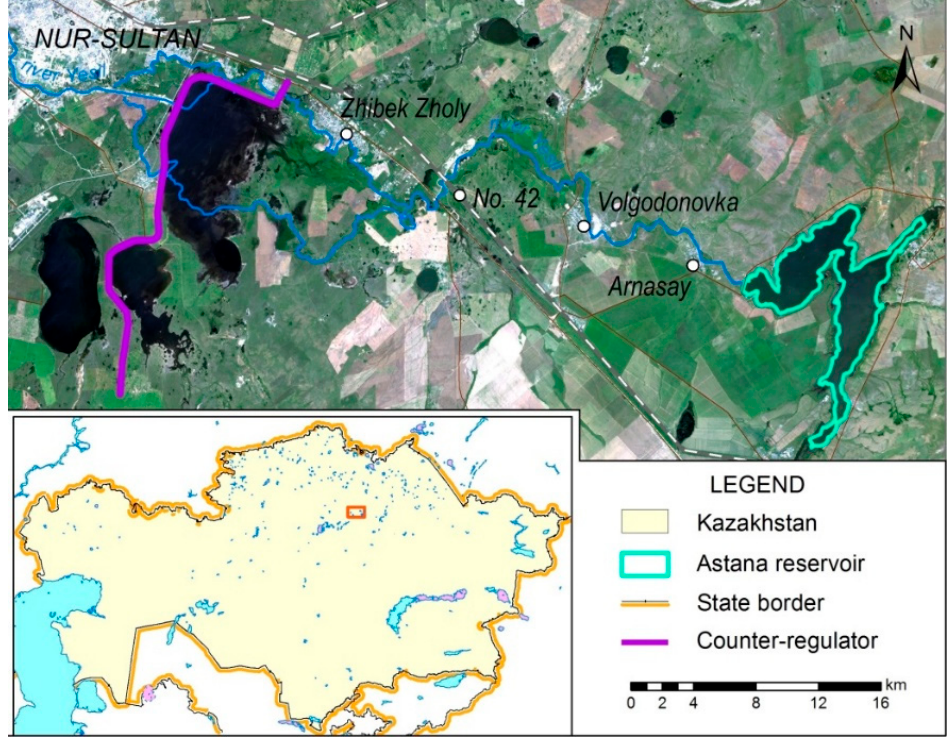
Figure 1. Location of the study area, hydraulic structures and settlements.